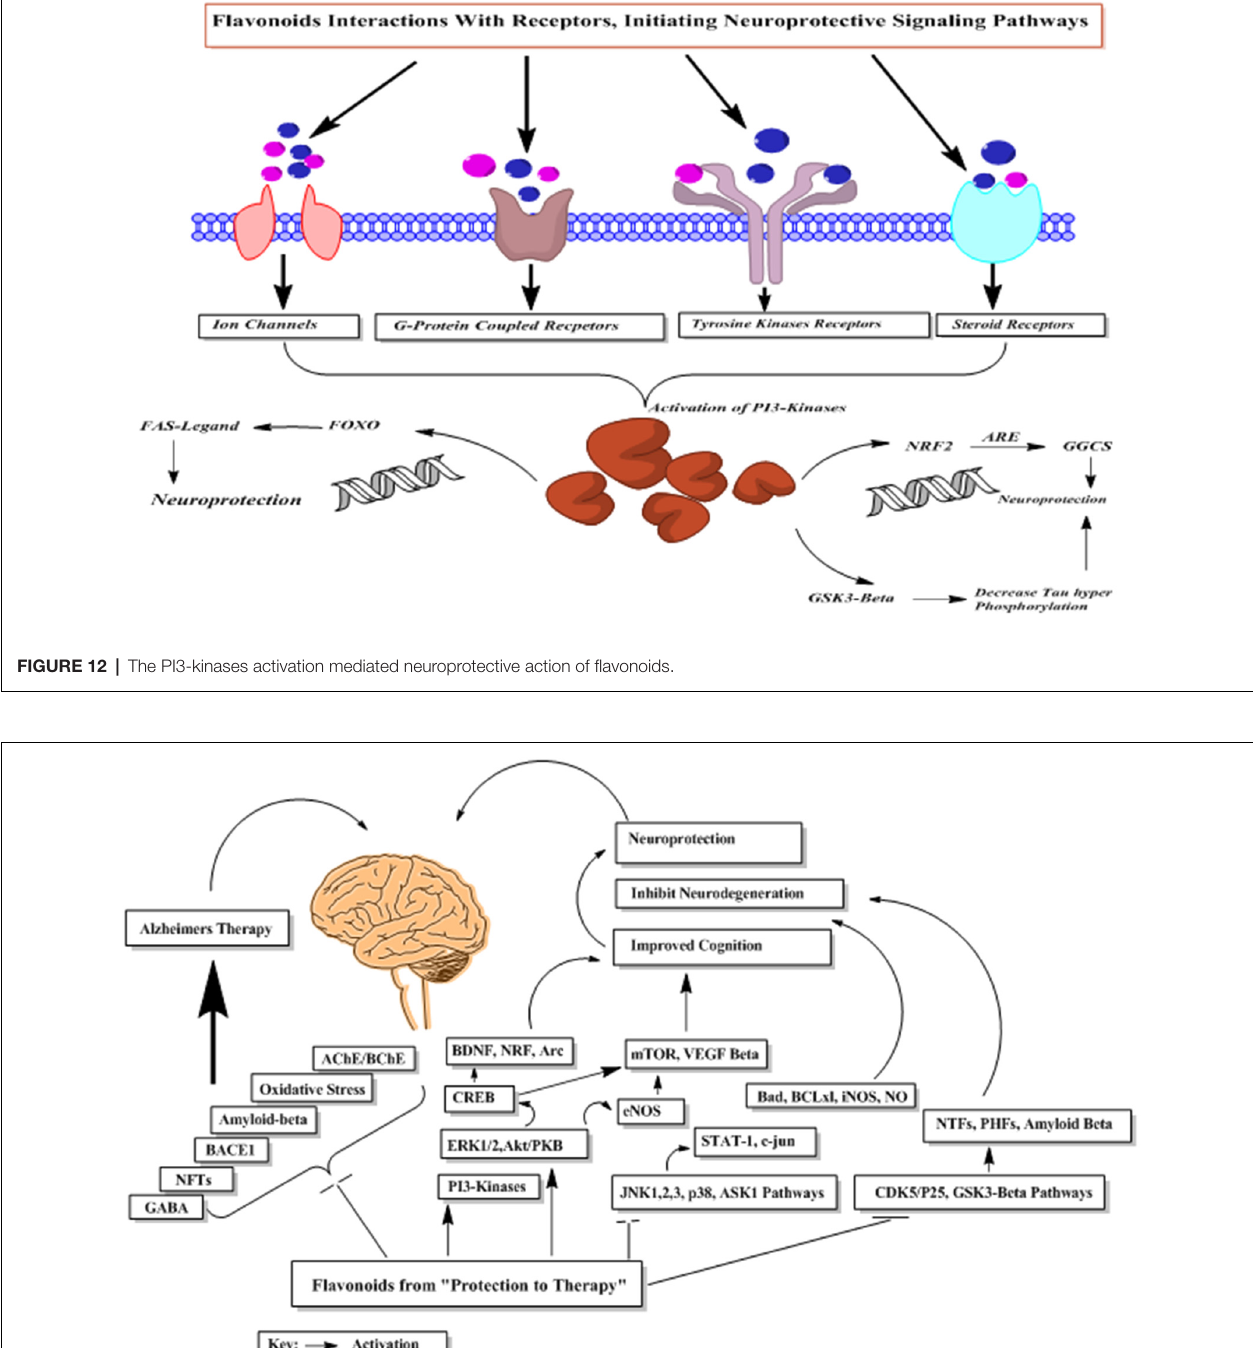
5-S-cysteinyldopamine (Vauzour et al., 2007b).